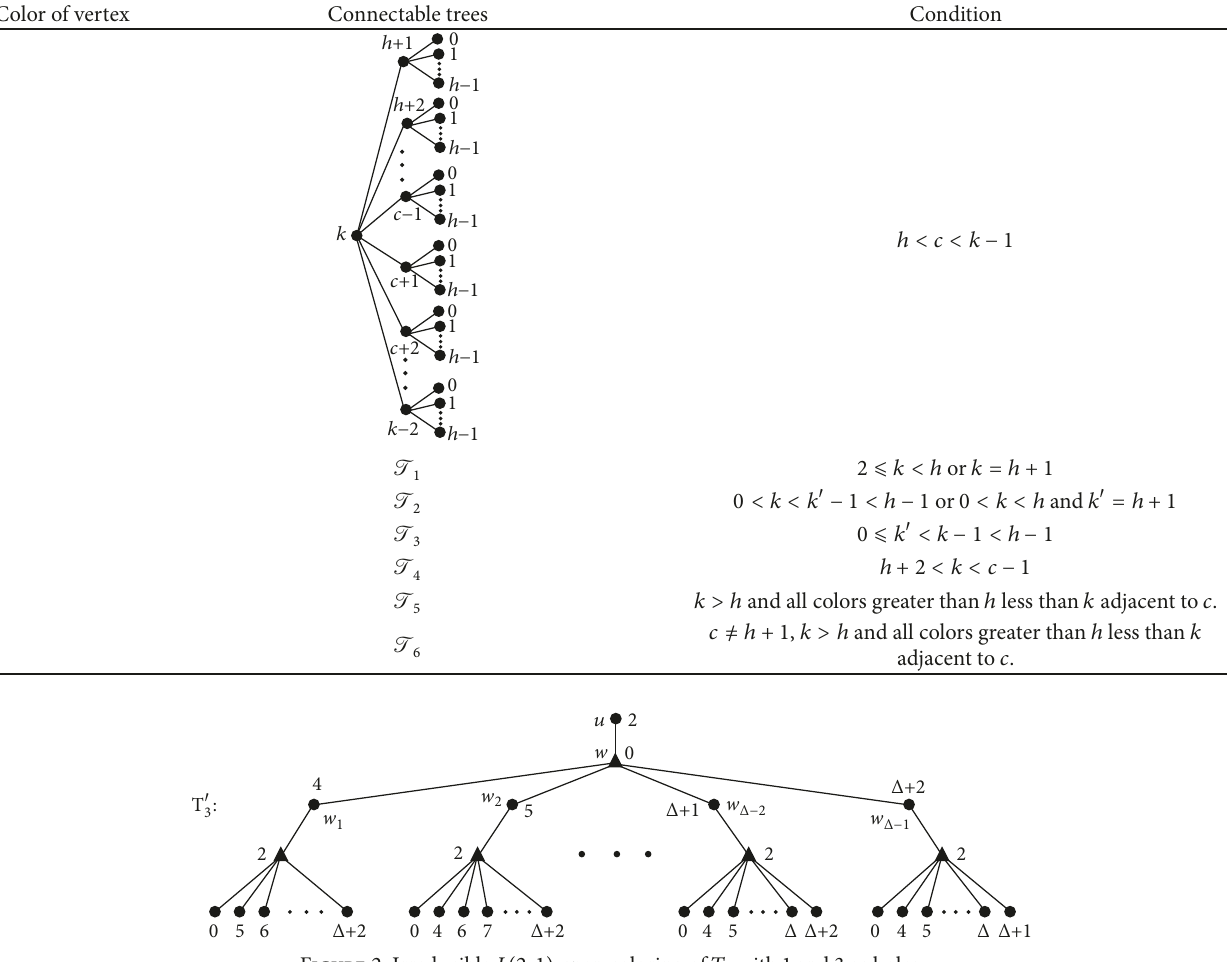
Figure 2: Irreducible 𝐿(2, 1) -span coloring of 𝑇 3 with 1 and 3 as